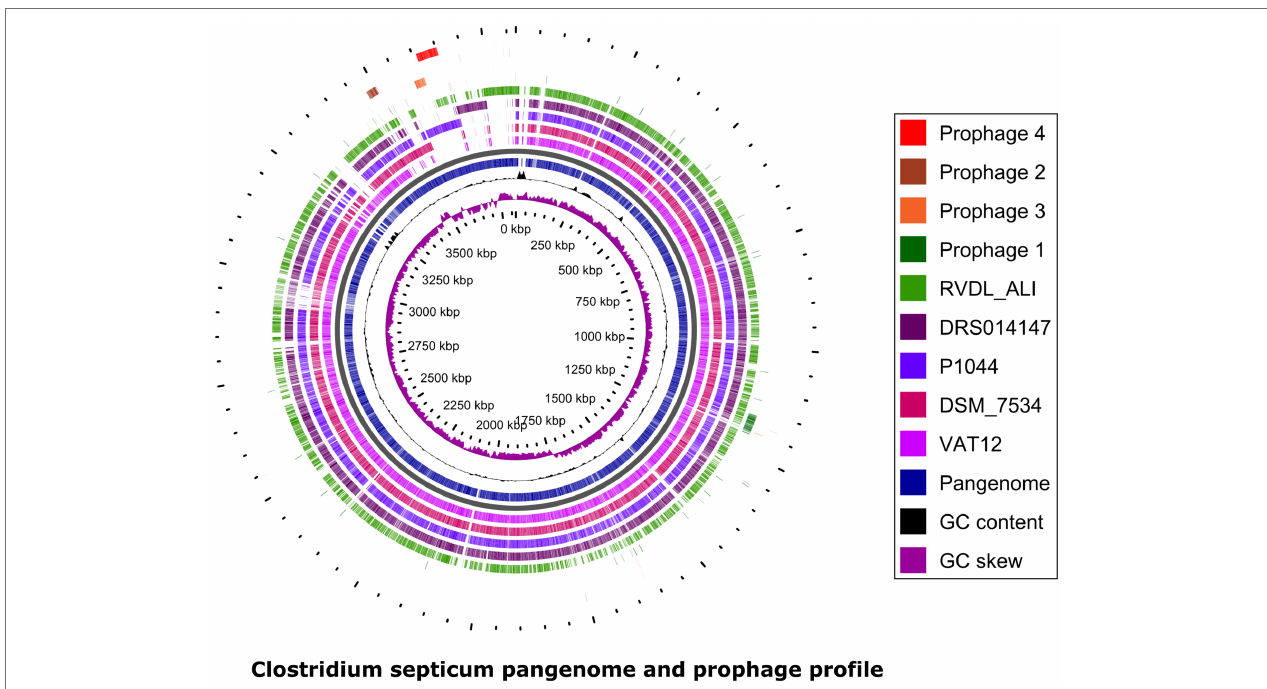
FIGURE 3 | Clostridium septicum pangenome prophage profile. The pangenome plot depicts BLASTP relatedness among protein coding genes in five C. septicum genomes to species pangenome. The plot also represents the GC content and GCskew. Prophages (1–4) mapped to C. septicum pangenome shows the shared and unique presence of few phages in all strains or some strains, respectively. Pangenome prophage profile was created using GView Server.